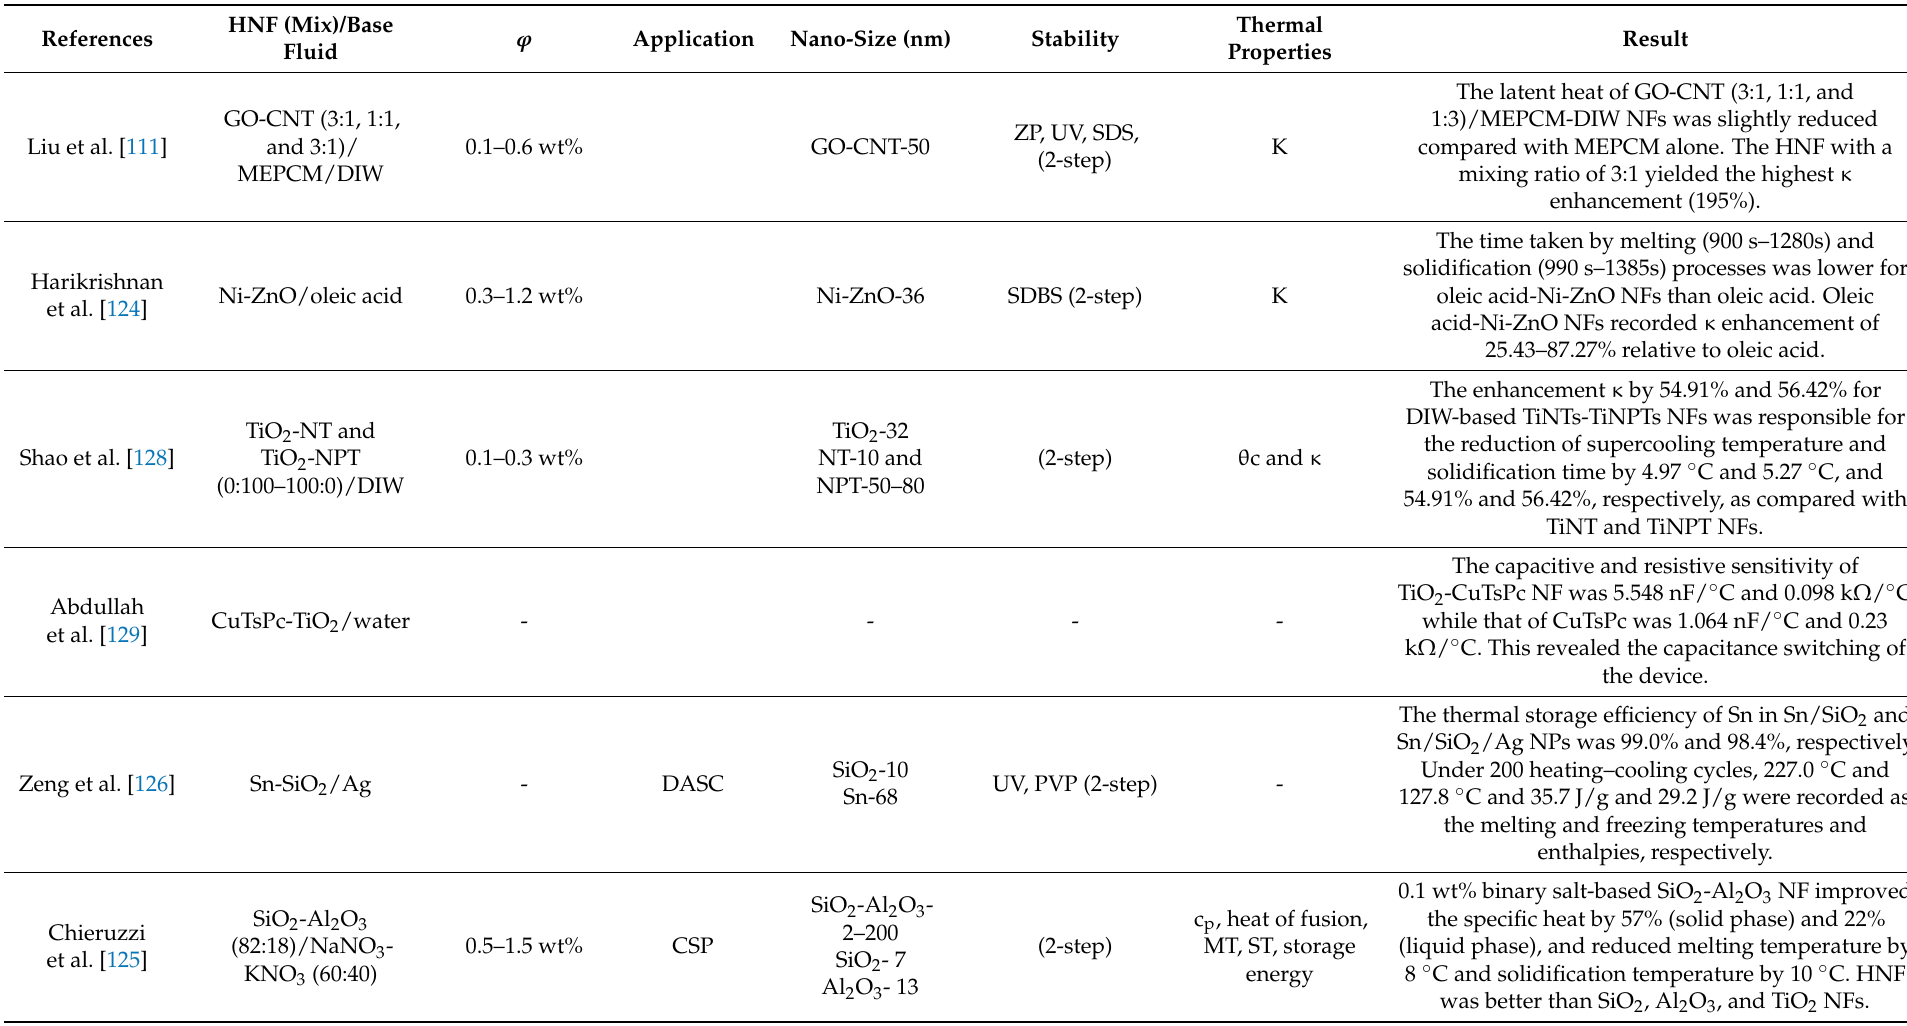
Table 4. Summary of stability tests, surfactants, process methods, thermal properties, and performances of different HNFs deployed in various solar collectors as thermal energy